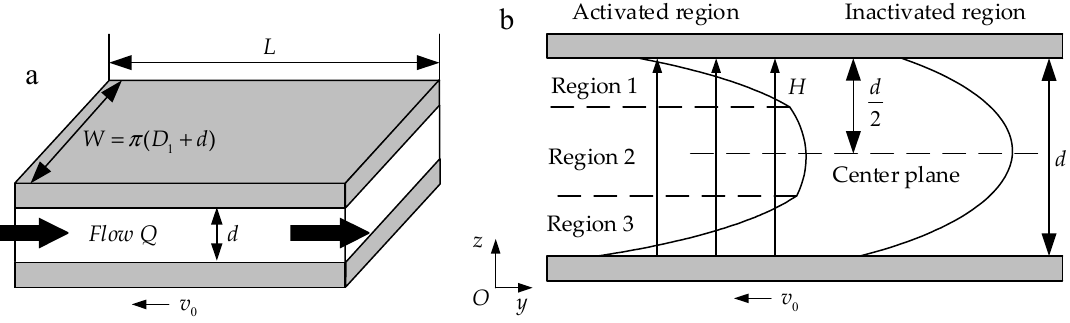
Figure 4. Rheological behavior of MR fluid.